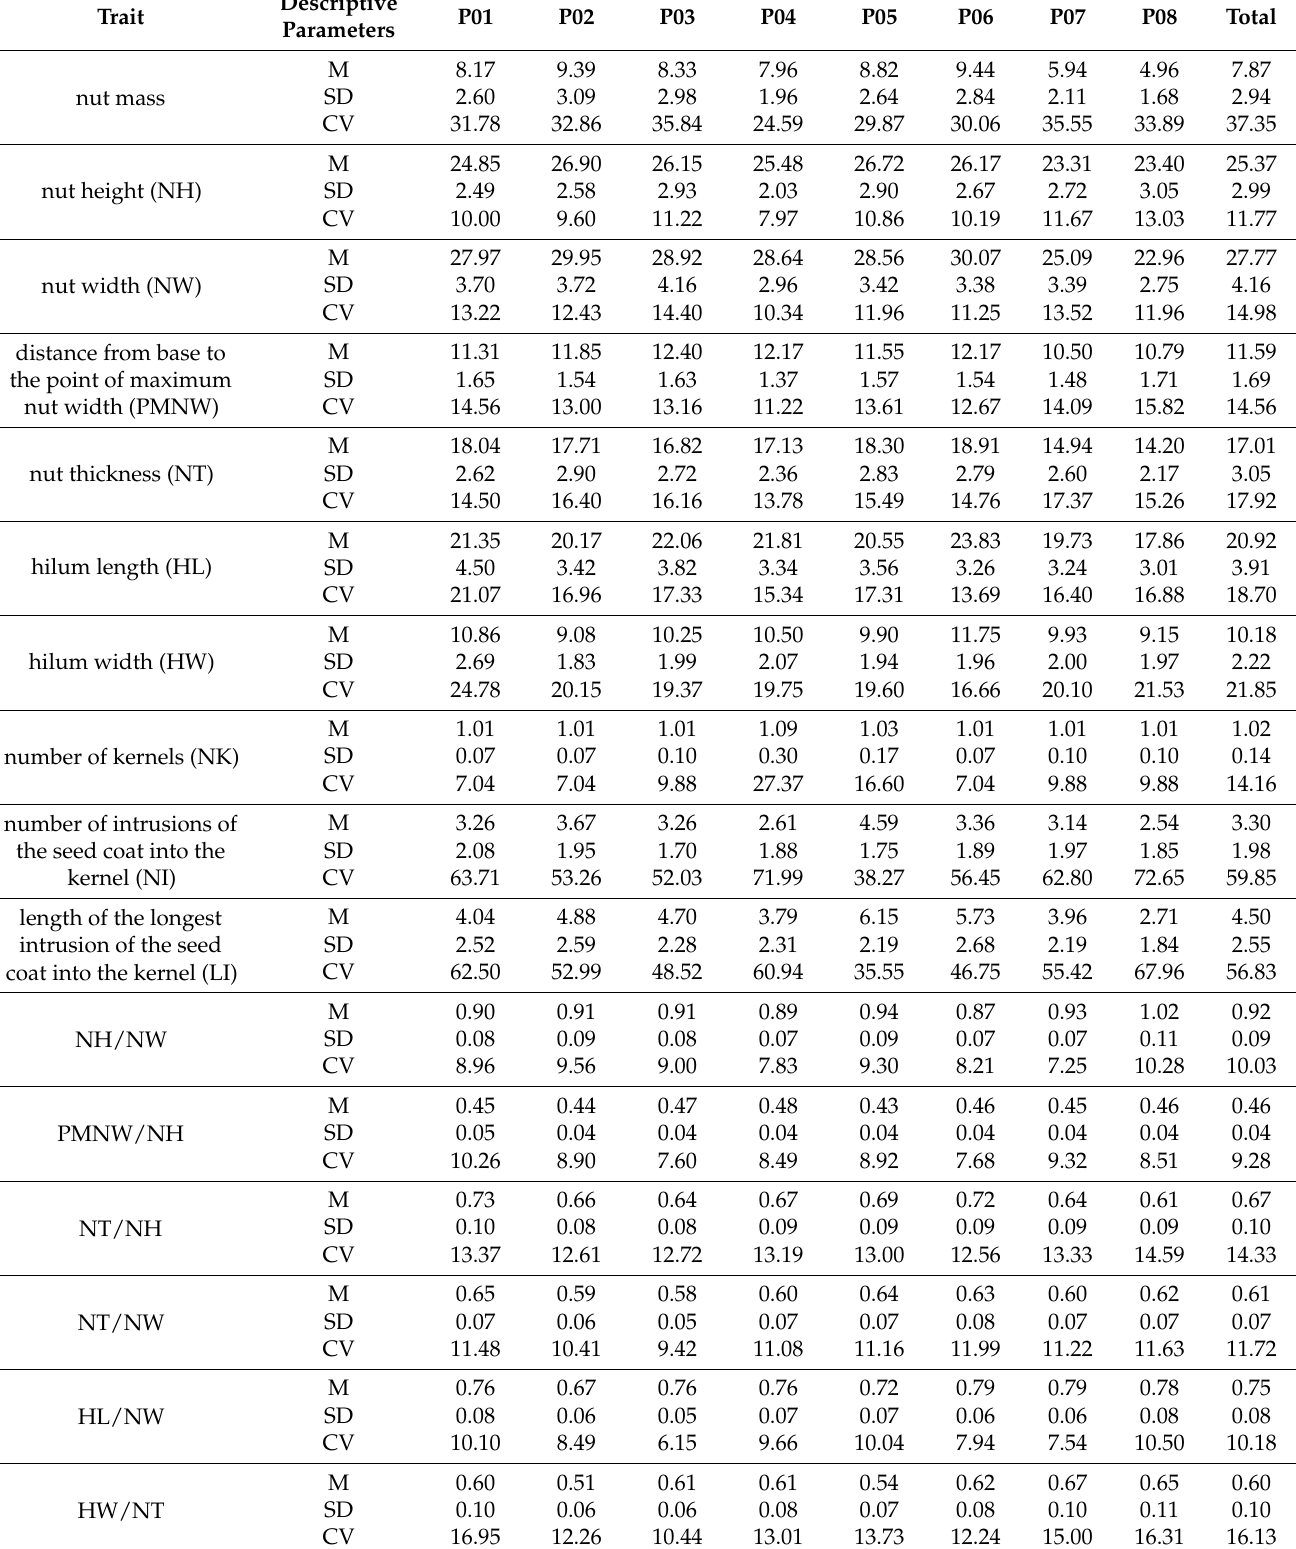
Table 2. Descriptive statistical parameters for studied morphometric traits. M—arithmetic mean; SD— standard deviation; CV—coefficient of variation (%). Acronyms of populations: P01—Combai;